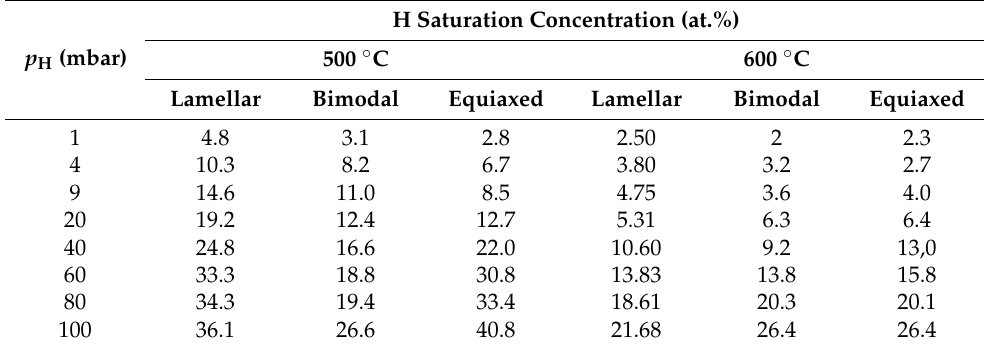
Table 3. Hydrogen saturation concentration coefficient at 500 ◦ C and 600 ◦ C for different solution treatment conditions, data from [15].